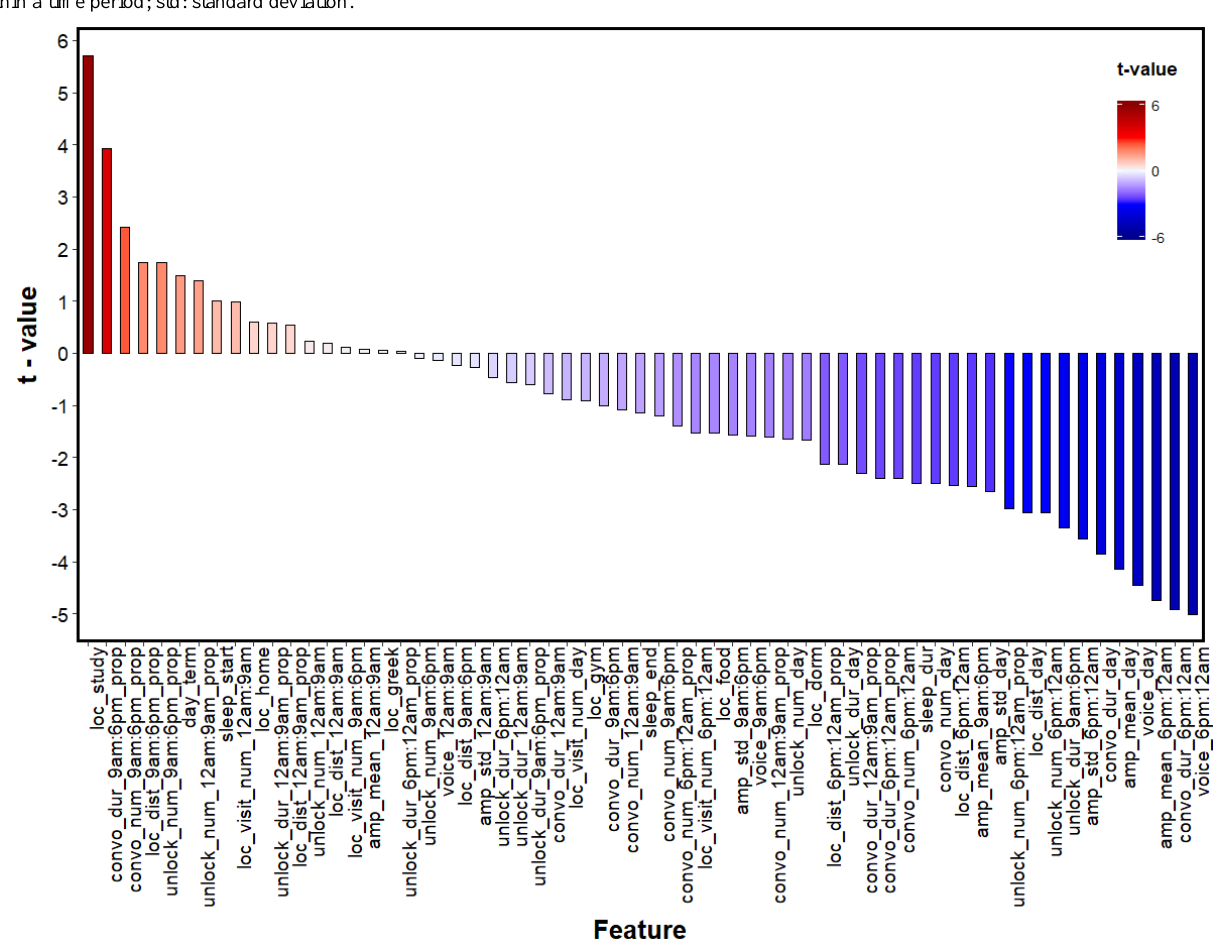
Figure 3. Relationship between stress and sensing features using t values to depict the relationship in a pairwise fashion. Amp: amplitude; convo: conversation; day: sensing data across an entire day; dist: distance; dur: duration; loc: location; num: number; prop: proportion of sensing data occurring within a time period; std: standard deviation.